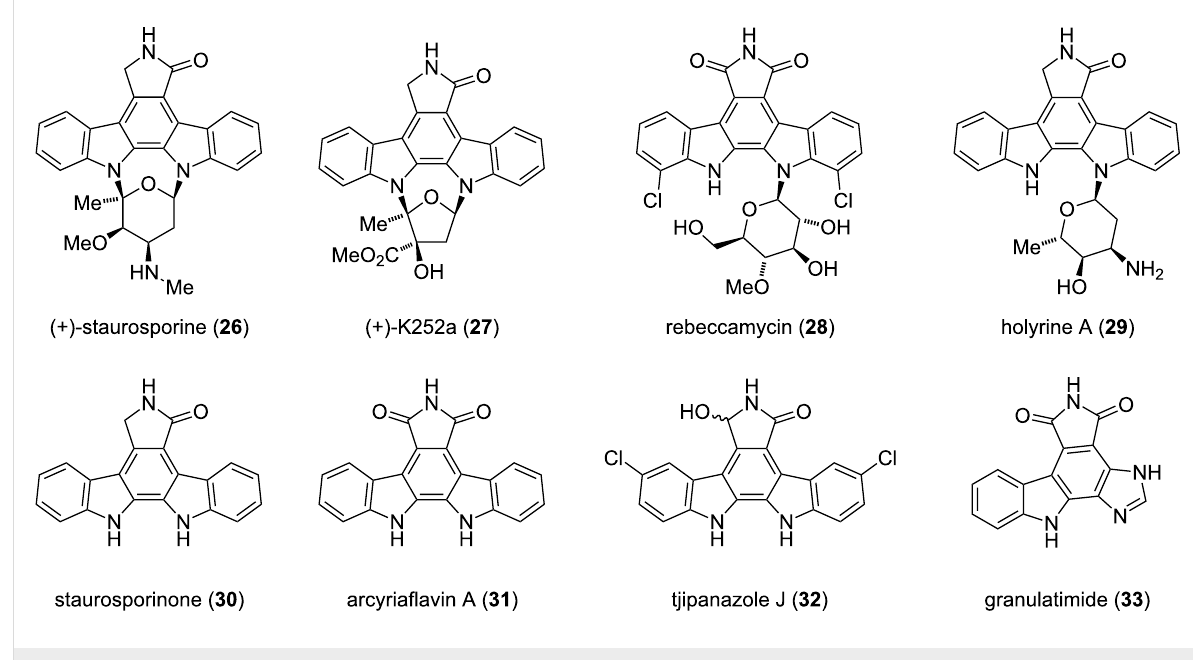
Figure 2: Representative members of the indolocarbazole alkaloid family.